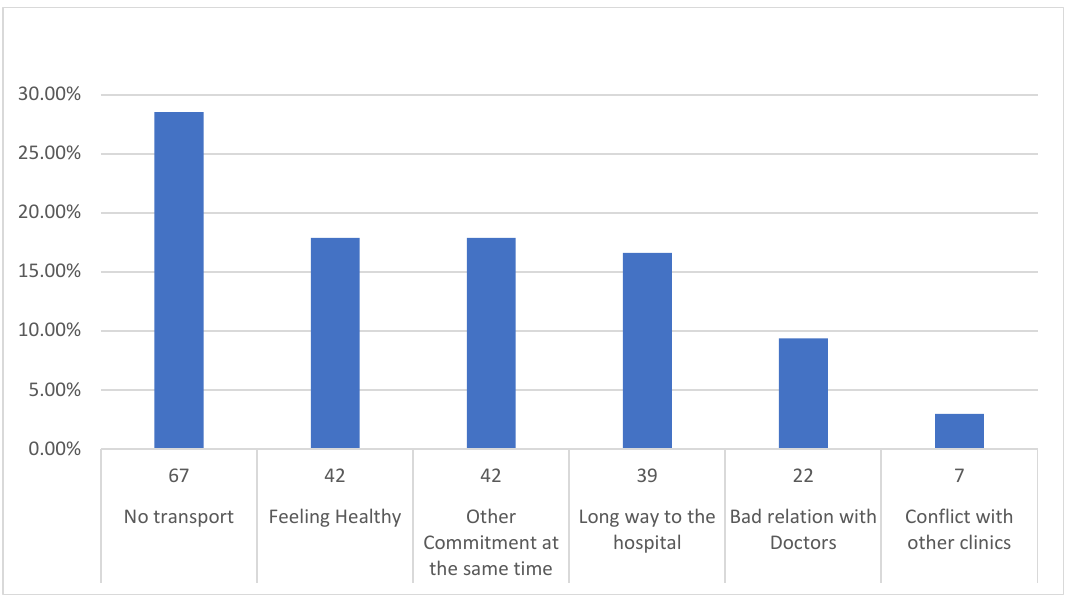
Figure 3. Reasons for missing clinical appointments among participants with SCD.